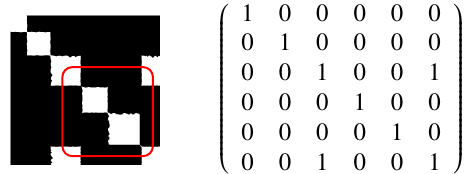
Figure 6 . Matrix representation for scanpath